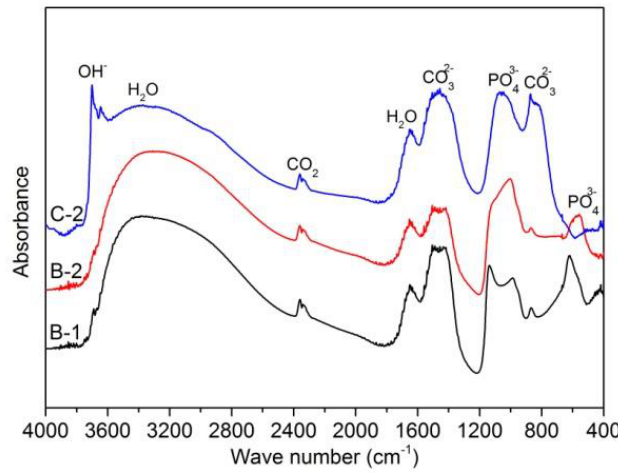
Figure 8. FTIR (Fourier-transform infrared spectroscopy) spectra of immersed samples B-1, B-2, and C-2. and C-2. Table 4. Corrosion potential ( E corr ) and corrosion current density ( I corr ) of the as fabricated samples.